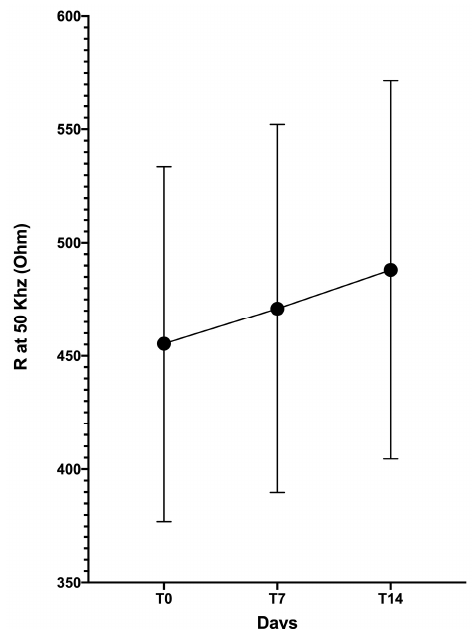
Figure 2. Increase in resistance (R) from baseline (T0); to 7 days (T7) and 14 days (T14). Table 2. BIA (bioimpedance analysis) parameter changes along the exercise program.